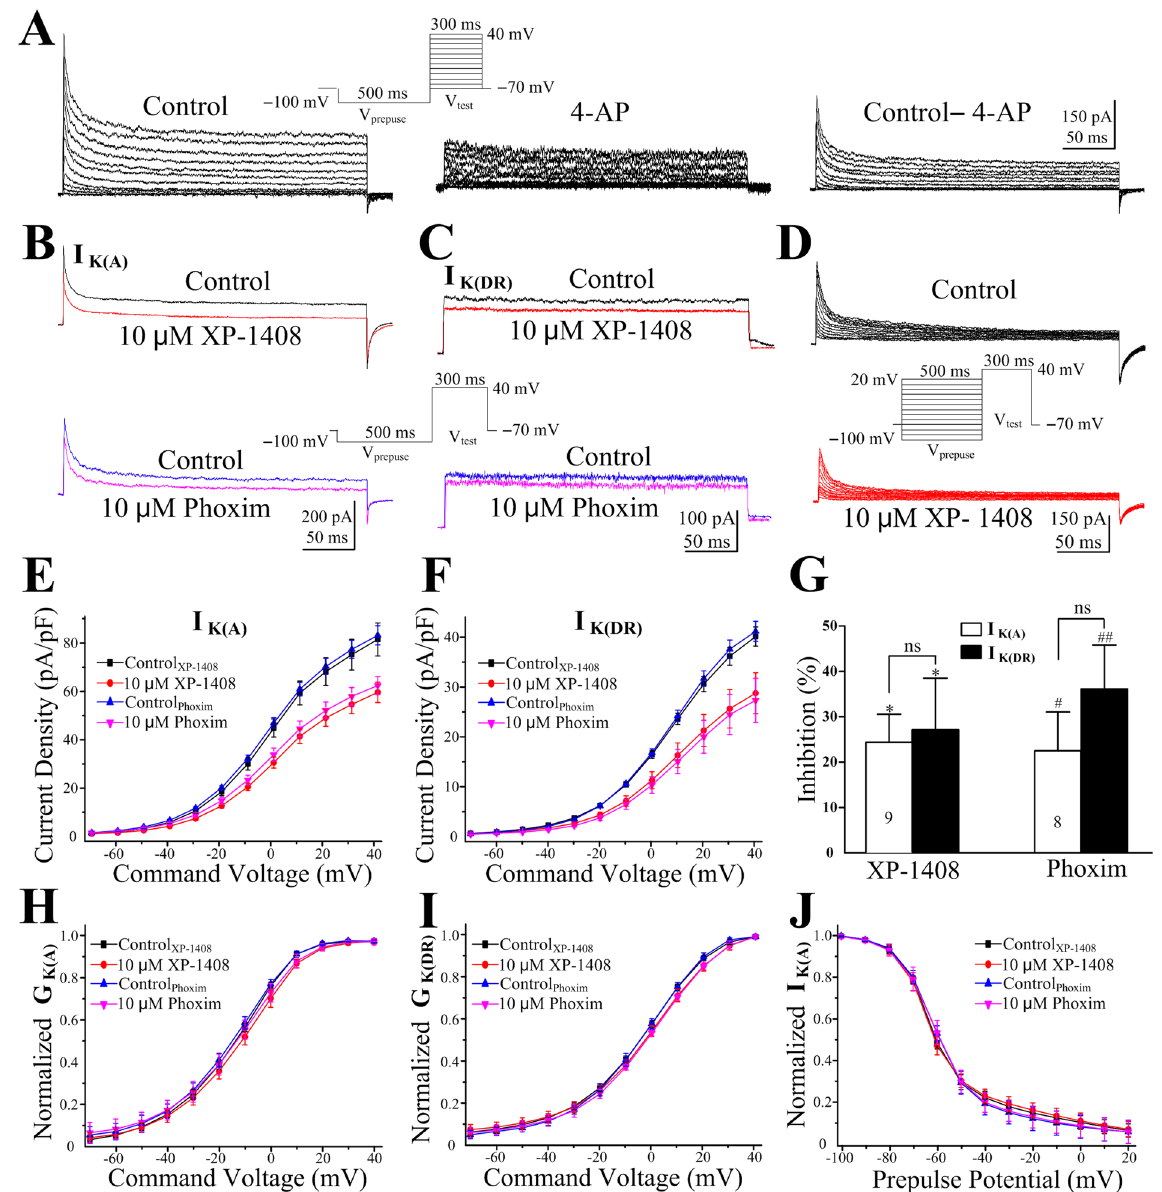
Figure 6. Effects of XP-1408 on I K(A) and I K(DR) in Drosophila PNs. ( A ) Representative voltage-gated potassium currents in PNs. Left: total outward potassium current stimulated with 300 ms depolarizing pulses from − 70 to + 40 mV in 10 mV steps following a hyperpolarizing prepulse of 500 ms to − 100 mV (inset). Middle: I K(DR) generated using the same protocol in the presence of 3 mM of 4-AP and 1 μ M of TTX. Right: I K(A) obtained by subtracting I K(DR) from total. The peak of the subtracted currents was referred to as I K(A) . ( B ) Representative superimposed current traces of I K(A) obtained at + 40 mV in control conditions, 10 min after the application of 10 μ M of XP-1408 and 10 μ M of phoxim. ( C ) Representative superimposed current traces of I K(DR) obtained at + 40 mV in control conditions, 10 min after the addition of 10 μ M of XP-1408 and 10 μ M of phoxim. Inset is the pulse protocol. ( D ) Representative inactivation traces of I K(A) before and after the addition of 10 μ M of XP-1408. Inset is the pulse protocol. ( E ) The effects of 10 μ M of XP-1408 and10 μ M of phoxim on the I-V curves of I K(A) . ( F ) The effects of 10 μ M of 1408 and10 μ M of phoxim on the I-Vcurves of I K(DR) . ( G ) Percentage inhibition of I K(A) and I K(DR) 10 min after XP-1408 (10 μ M) and phoxim (10 μ M) application, normalized to control values (100%). (#) * P < 0.05 vs. control (I K(A) or I K(DR) ), (##) ** P < 0.01 vs. control (I K(A) or I K(DR) ). ns, not significant, P > 0.05. Bar represent means ± SEM from indicated number of neurons. ( H ) The effects of 10 μ M of XP-1408 and 10 μ M of phoxim on the steady-state activation curves of I K(A) . ( I )The effects of 10 μ M of XP-1408 and 10 μ M of phoxim on the steady-state activation curves of I K(DR) . ( J ) The effects of 10 μ M of XP-1408 and 10 μ M of phoxim on the steady-state inactivation curves of I K(A)